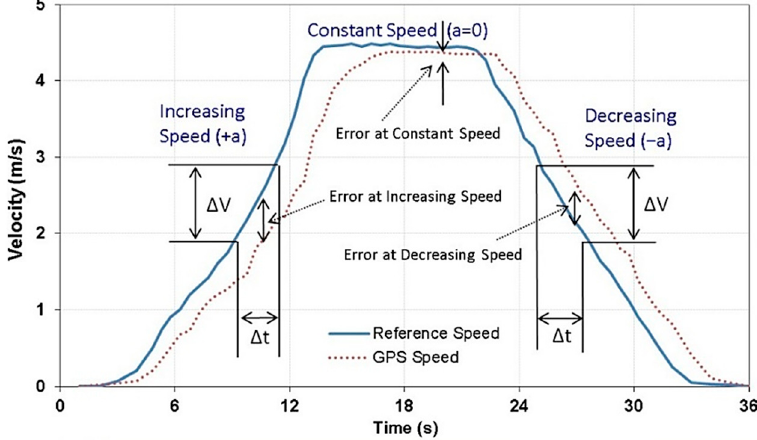
Figure 4. Calculation of the mean acceleration and the mean speed difference (error) values.